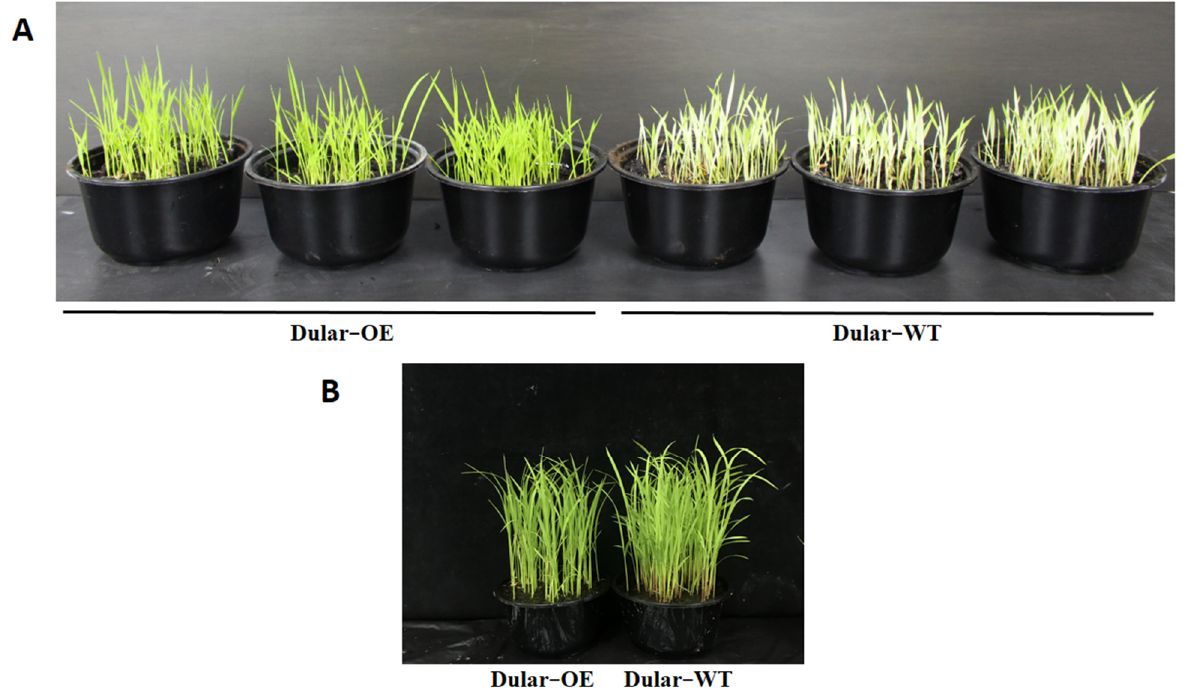
Figure 2. ( A ) Responses of Dular-WT and Dular-OE accessions to low temperature. ( B ) Responses of Dular-WT and Dular-OE accessions to normal temperature.